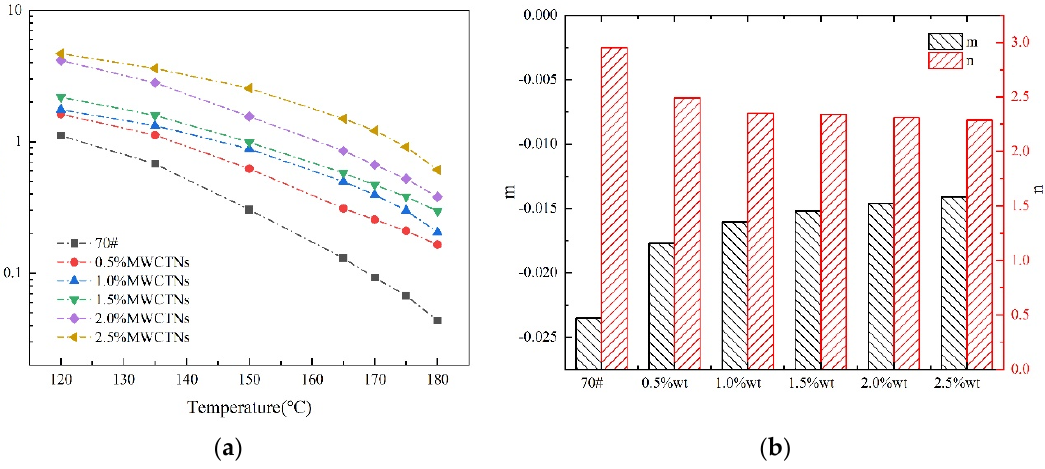
Figure 5. ( a ) Viscosity ‐ temperature response curves of MWCNTs ‐ MA; ( b ) Curve slope for